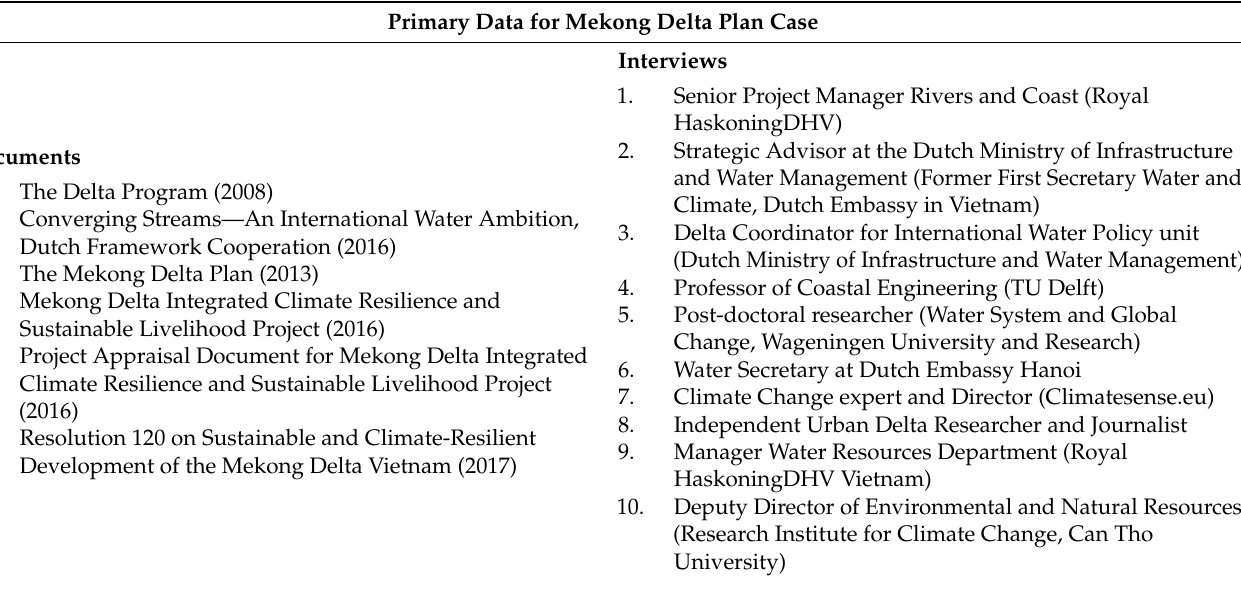
Table 2. Overview of documents and interviews for the data